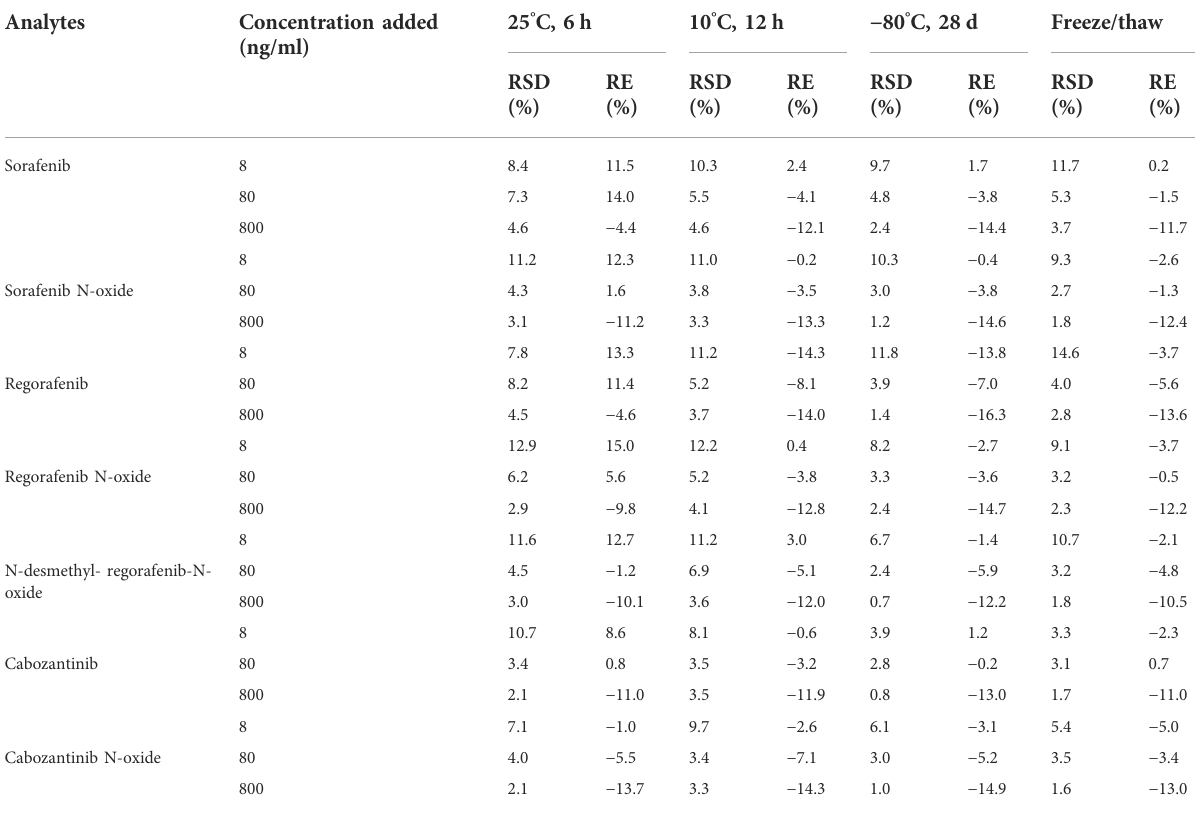
TABLE 4 The stability of the analytes from plasma in rats under different conditions.